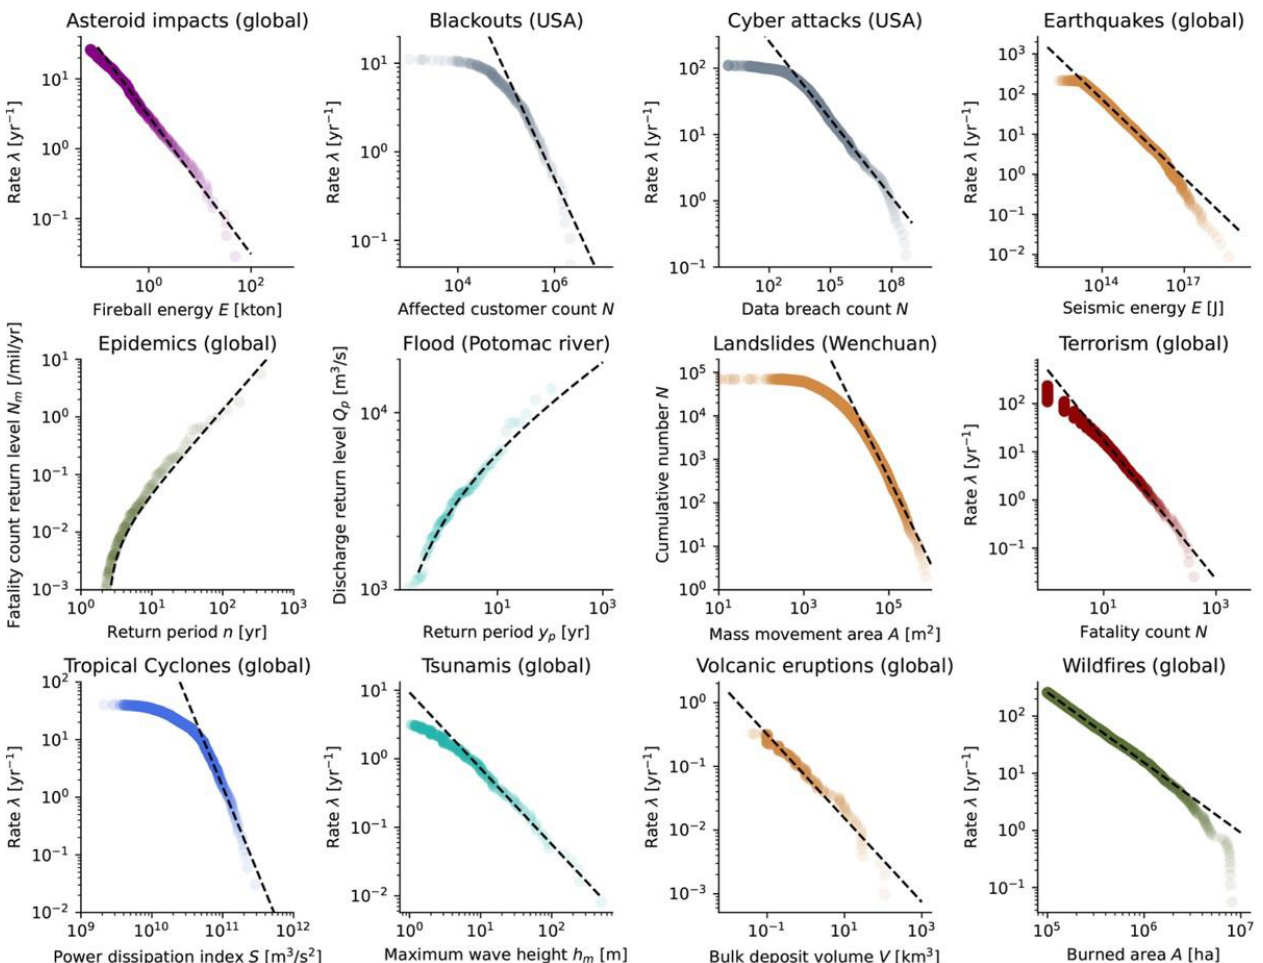
Figure 5. Size distribution of various perils, fitted by a simple power-law (most perils), a GEV distribution (river flooding), or a GPD (epidemics). Note that the results are sensitive to the choice of minimum size threshold, with fitted parameters to be used carefully when extrapolating.